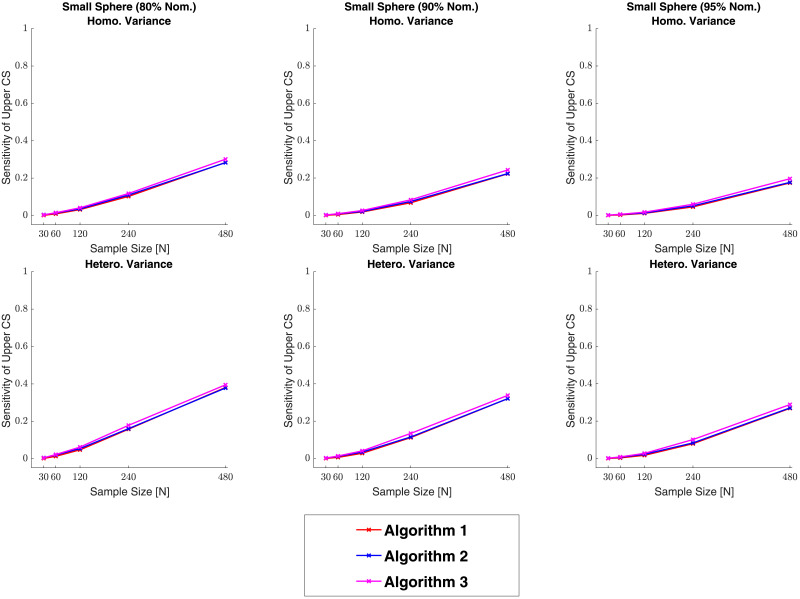
Sensitivity results for the small sphere signal, with homogeneous (top row) and heterogeneous (bottom row) Gaussian noise structures.